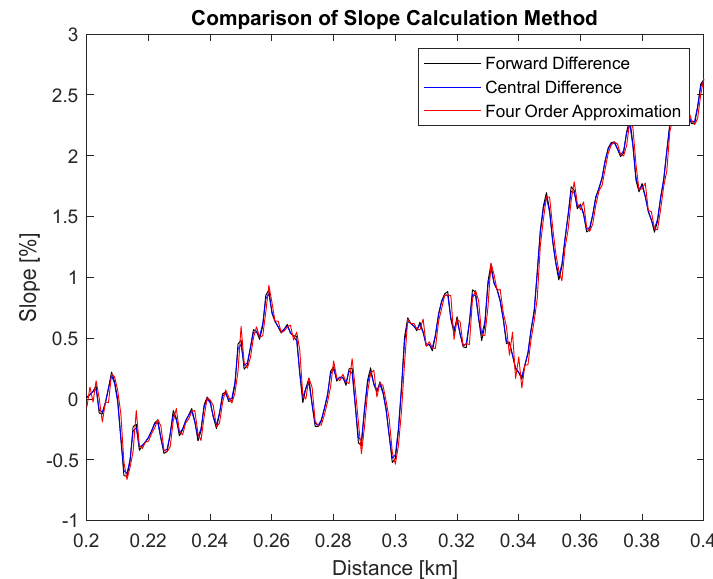
Figure 16. The slope calculation results with different methods.